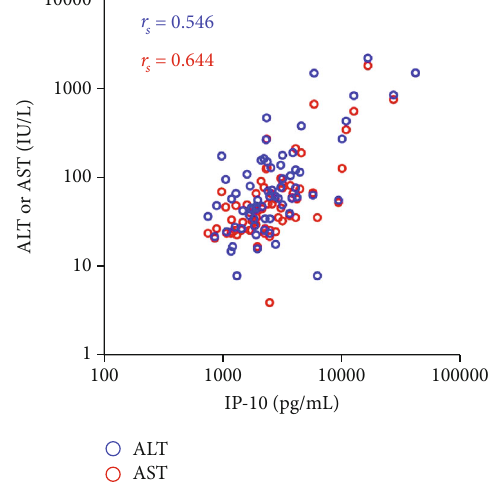
Figure 2: Correlation of the circulating IP-10 with ALT and AST concentrations in chronic hepatitis B patients. Correlations were assessed using the Spearman correlation coe ffi cient ( r s